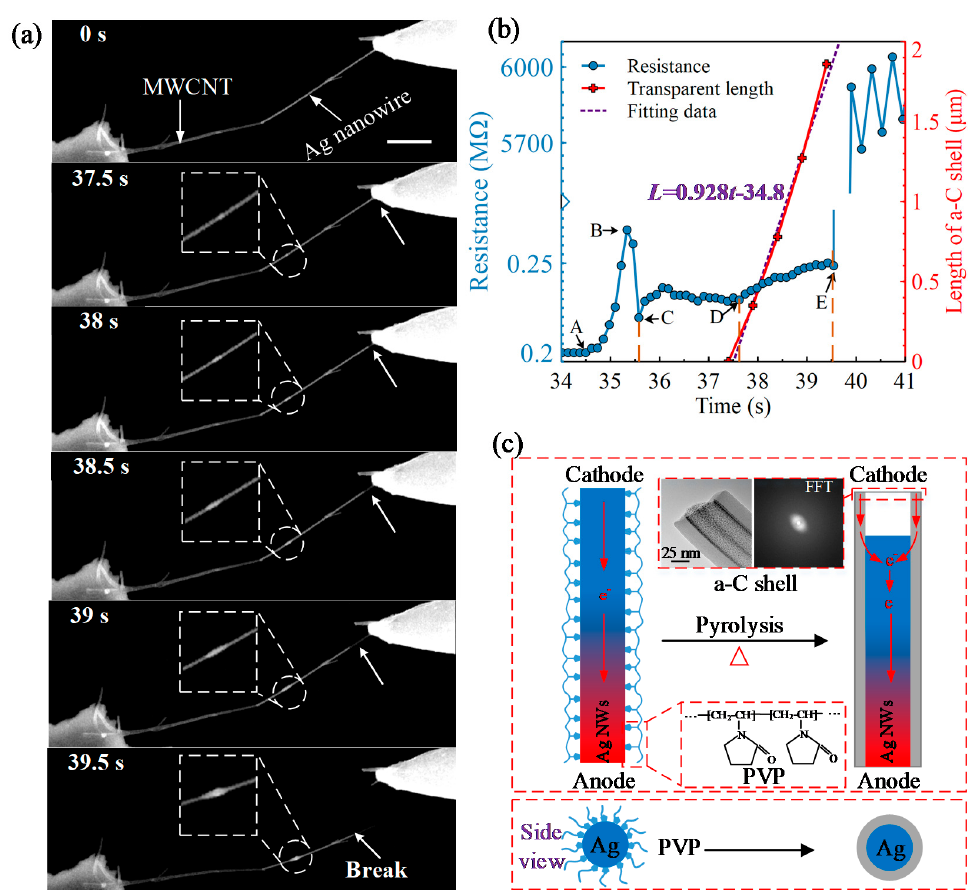
Figure 2. Controllable melting of the encapsulated Ag inside PVP shell. ( a ) Time-resolved melting and flow of the wrapped Ag. Scale bar: 2 µm; ( b ) Melting and flow state detection of the internal Ag based on resistance variation. The AC stage indicates the phase transition of the encapsulated Ag while the CD and DE stages represent the melting and flow states of Ag, respectively; ( c ) Schematic illustration of transparent shell formation and Ag flow mechanism. The inset HRTEM image (left) predicts the enlarging porous a-C shell, and its corresponding fast Fourier transformation (FFT) image is shown on the right.